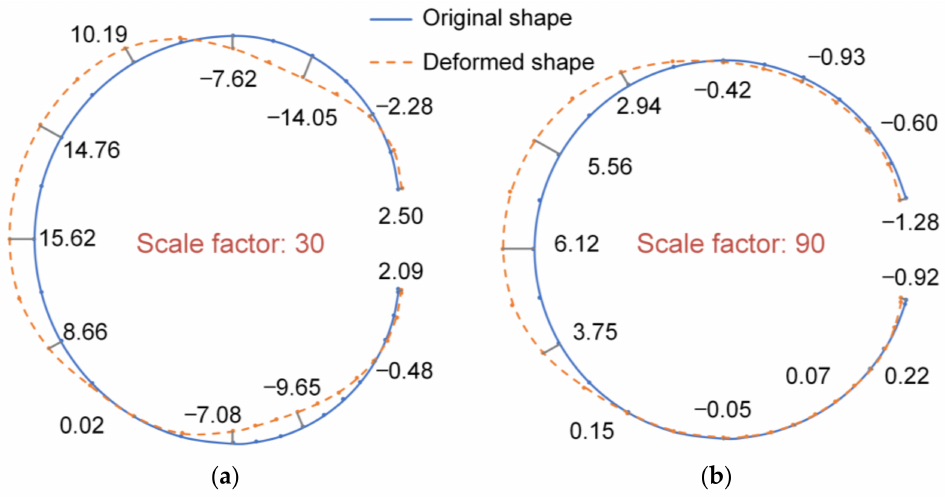
Figure 19. Radial deformation of section 4 (mm): ( a ) non-circle case; ( b ) circle case.